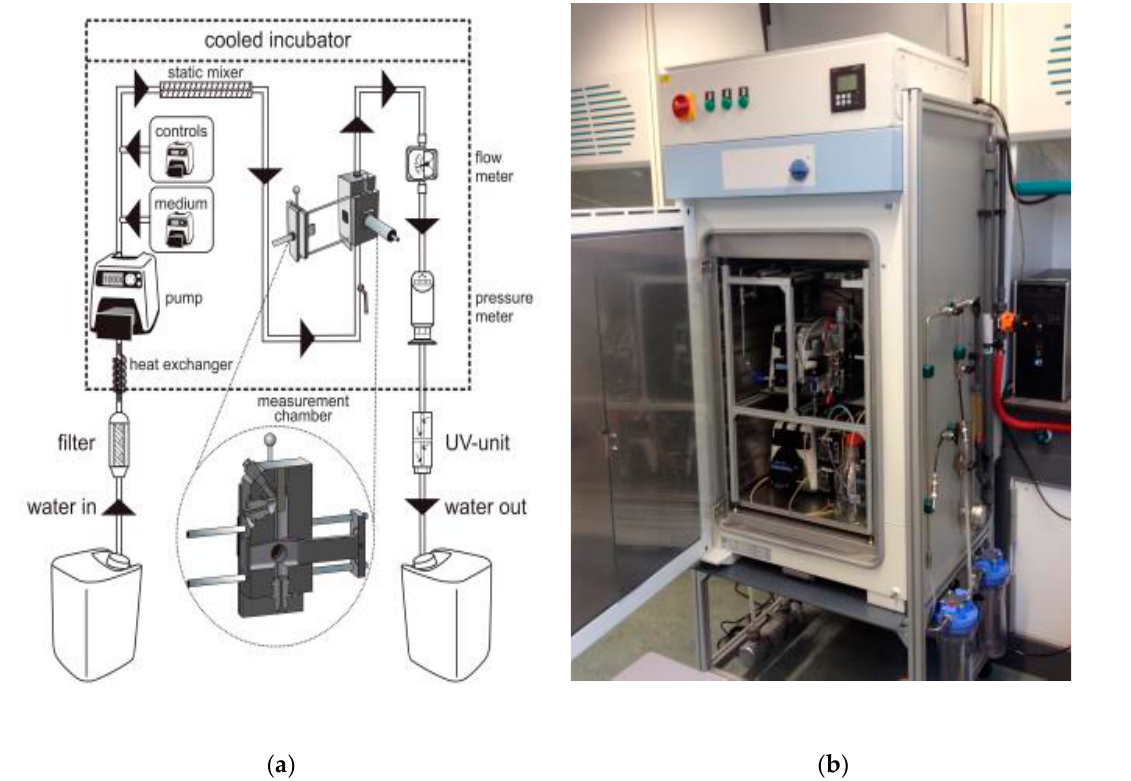
Figure 3. ( a ) A schematic overview of the sensor, the inside of the measurement chamber is shown in the enlargement. ( b ) Photograph of the sensor at monitoring station Keizersveer. The filters were attached to the side of the sensor (on the right). The UV-unit is visible on the bottom